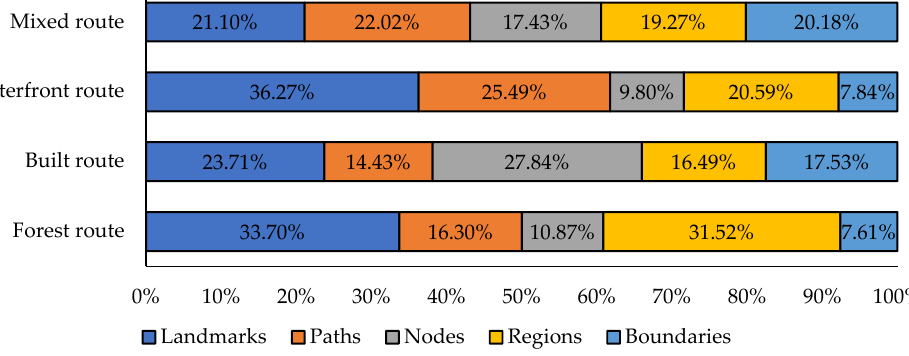
Figure 5. Frequency distribution of familiar units in the cognition maps of four urban forest park routes.